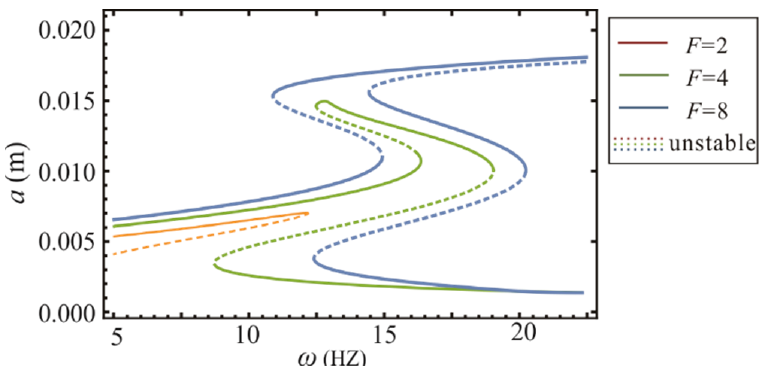
Figure 5. The stability of the solutions at different amplitudes F , and the dashed lines are the unstable solution which is introduced by Equation (16).